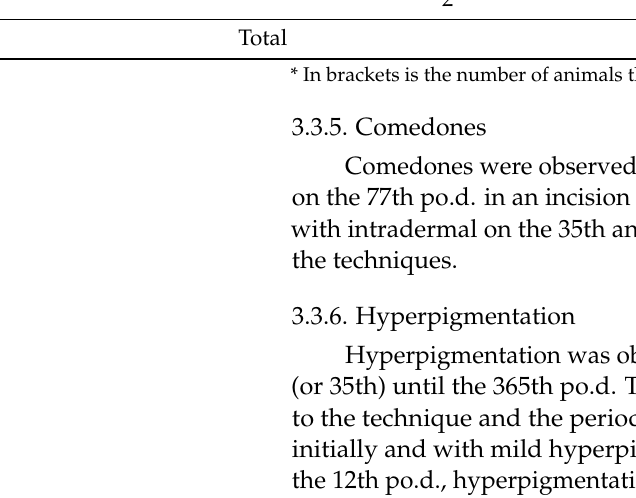
Table 2. Cases of inflammation for each technique. Score Staples Glue Intradermal Cases of